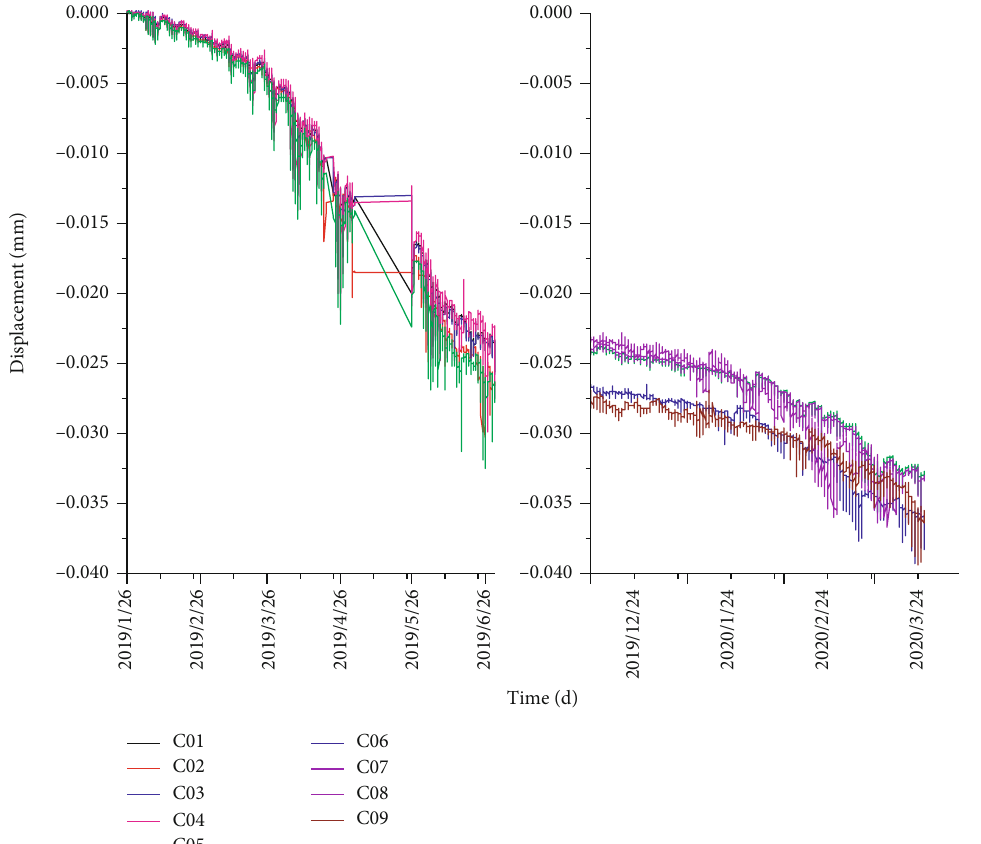
Figure 8: Roof settlement monitoring